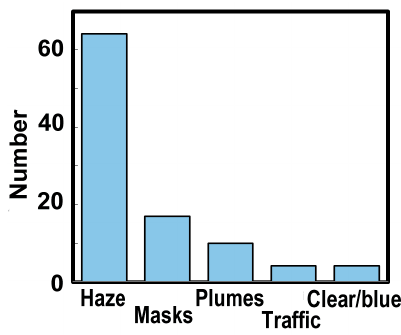
Figure 5. The number of representations of haze, surgical masks, plumes from a chimney and blue or clear skies from pictures in 70 articles about air pollution published in the South China Morning